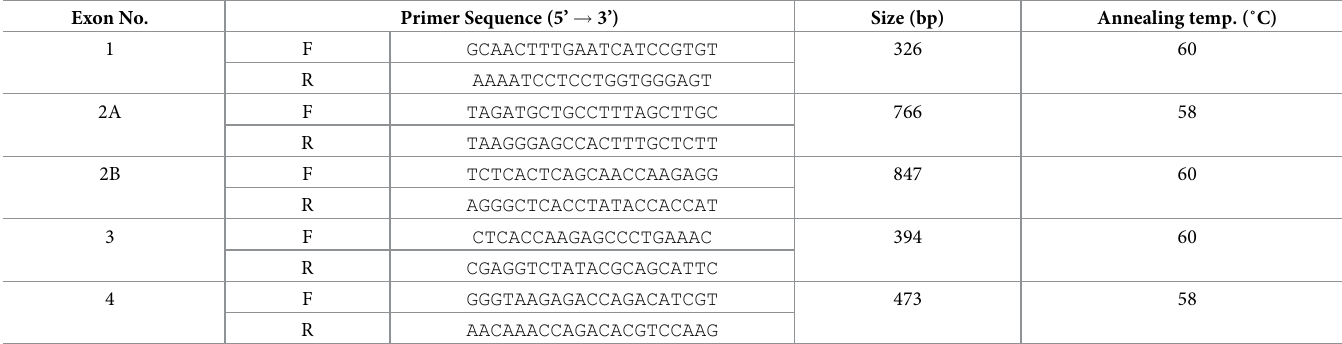
Table 3. Primer sequences for amplification of 4 selected exons of ATP7B gene. Exon